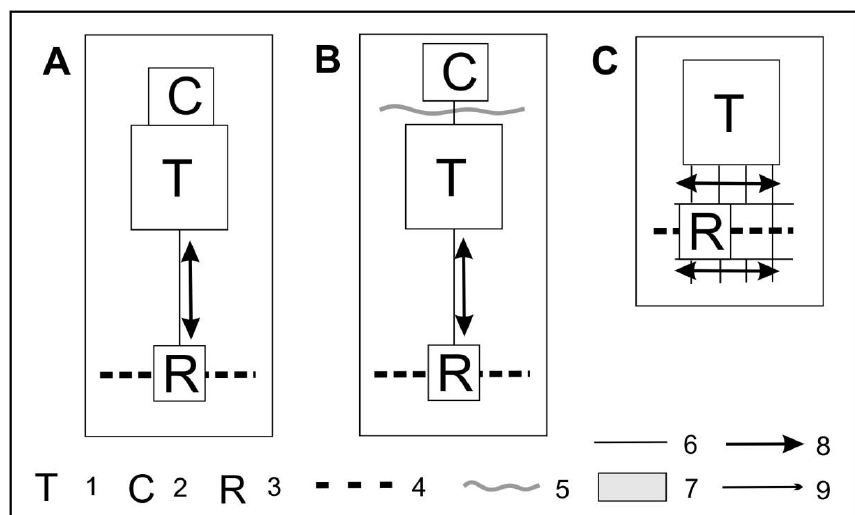
Fig. 7. Urban layout model of location towns and direction of their development: A – Działdowo ( Soldau ), B – Ełk ( Lyck ), C – Grajewo (Source: author’s own study) 1 – location town, 2 – Teutonic castle, 3 – railway station with its buildings, 4 – railway line, 5 – lakeshore, 6 – street layout, 7 – built-up area, urban development intensity: 8 – strong, 9 –